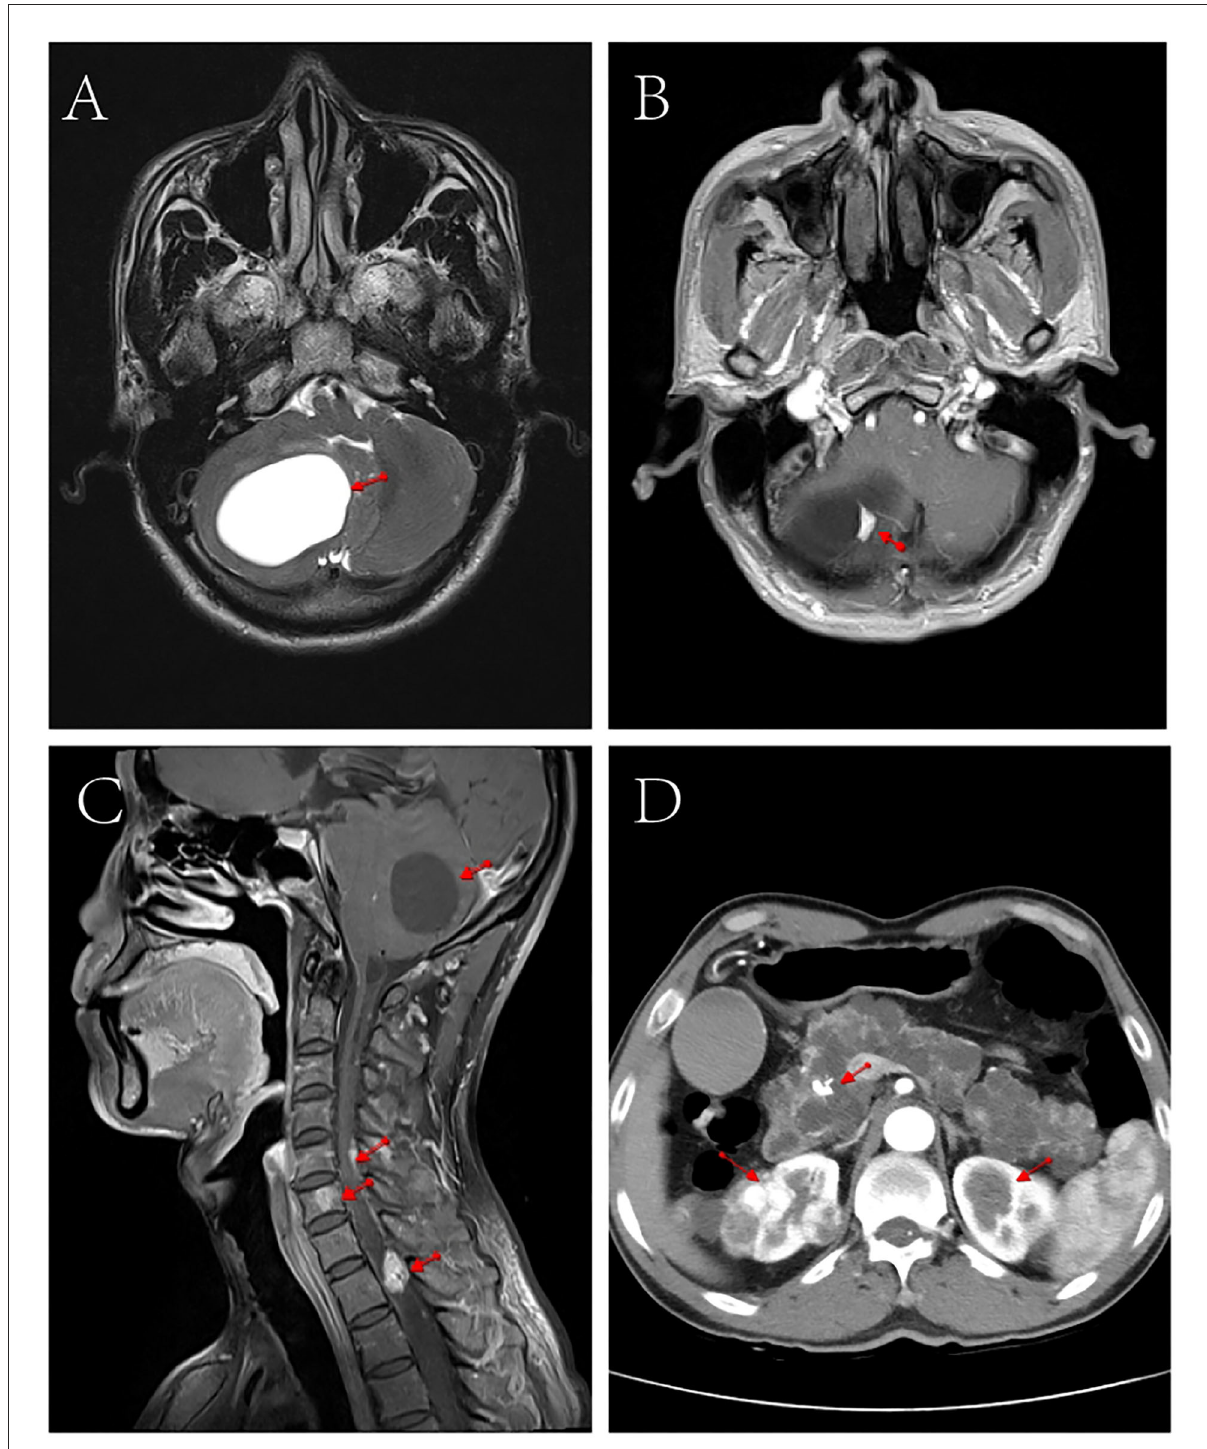
FIGURE1 CT and MRI scan images of the patient. (A) Cranial MRI showed space- occupying lesions in the right cerebellar hemisphere. (B) Cranial enhanced MRI showed nodular enhancement in the right cerebellar hemisphere lesion (1.0cm × 0.6cm). (C) Contrast-enhanced MRI of the head and neck showed narrowing of the space in the fourth ventricle, multiple nodular and tortuous line-like enhancement in the spinal cord from C5 to T2, and round abnormal enhancement in the C6 vertebrae. (D) Abdominal enhanced CT showed multiple round soft tissue density lesions and multiple cystic low-density lesions in both kidneys, multiple low-density lesions of different sizes in the pancreas, and calcifications in the head of the